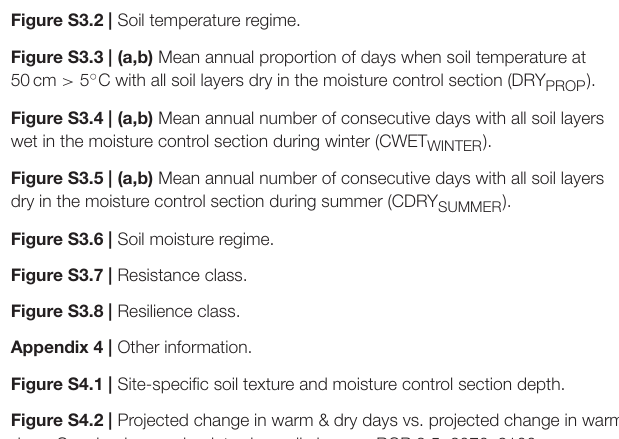
Figure S1.1 | Mean annual temperature (MAT). Figure S1.2 | Mean annual precipitation (MAP). Figure S1.3 | Ratio of mean annual precipitation to mean annual potential evapotranspiration (MAP/PET). Figure S1.4 | Mean annual soil temperature at 50cm depth (T50 ANN ). Figure S1.5 | Mean summer soil temperature at 50cm depth (T50 SUM ). Figure S1.6 | Soil temperature regime. Figure S1.7 | Mean annual days with soil temperature at 50cm > 5 ◦ C (DAYS WARM ). Figure S1.8 | Mean annual days with all soil layers dry in the moisture control section when soil temperature at 50cm > 5 ◦ C (DAYS WARMDRY ).